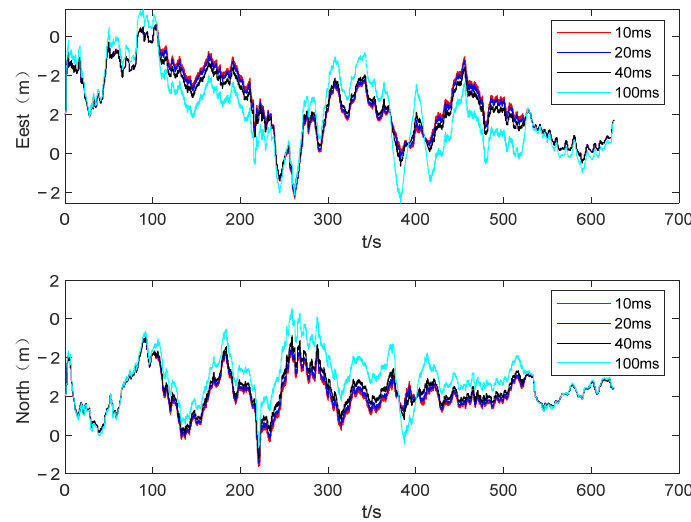
Figure 9. Error situation of CKF filter under different delay conditions.